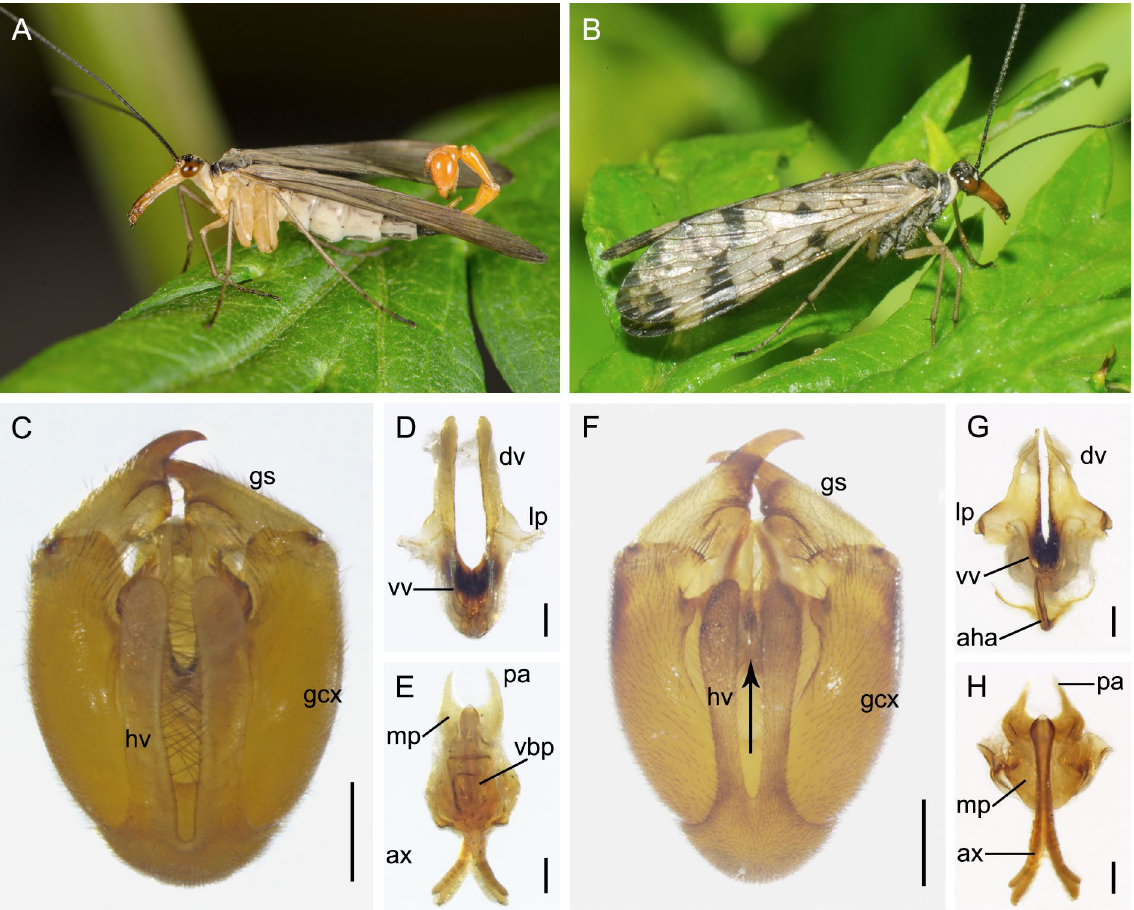
Fig. 1. Comparisons of Cerapanorpa obtusa (Cheng, 1949) (A, C–E) in central China and Panorpa acutipennis Hua, 1998 (B, F–H) from Northeast Asia. A–B . Male live habitus. C, F . Male genital bulb in ventral view. D, G . Aedeagus in ventral view, arrow indicates the aedeagal hamulus. E, H . Female medigynium in ventral view. Abbreviations: aha = aedeagal hamulus; ax = axis; dv = dorsal valve; gcx = gonocoxite; gs = gonostylus; hv = hypovalve; lp = lateral process; mp = main plate; pa = posterior arm; vbp = ventral basal plate; vv = ventral valve. Scale bars: C, F = 0.5 mm; D–E, G–H = 0.2